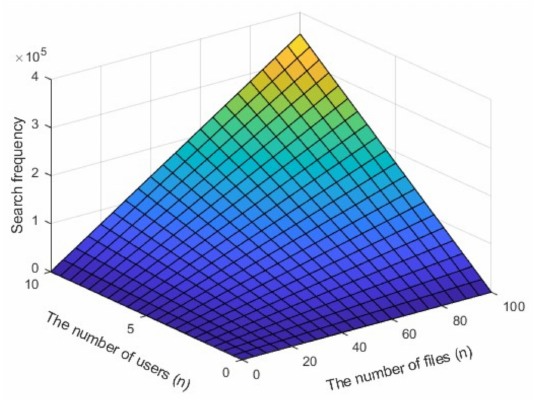
Figure 11. The search frequency used in batch